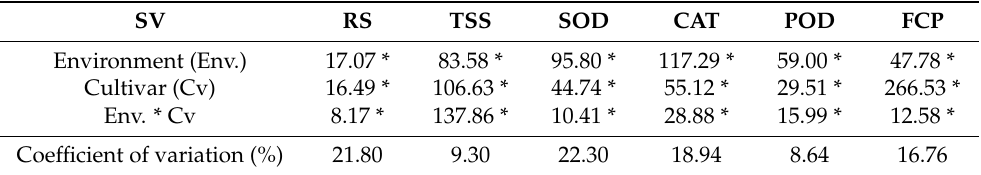
Table 1. Summary of analysis of variance for reducing sugar content (RS); total soluble sugar content (TSS); the activity of the enzymes superoxide dismutase (SOD), catalase (CAT), and peroxidase (POD); and commercial fresh matter (FCP) of iceberg lettuce cultivars under different shade screens. SV RS TSS SOD CAT POD FCP Environment (Env.) Cultivar (Cv) Env. * Cv Coefficient of variation (%) 21.80 9.30 22.30 18.94 16.76 SV, source of variation. * Significant at 5% probability ( p ≤